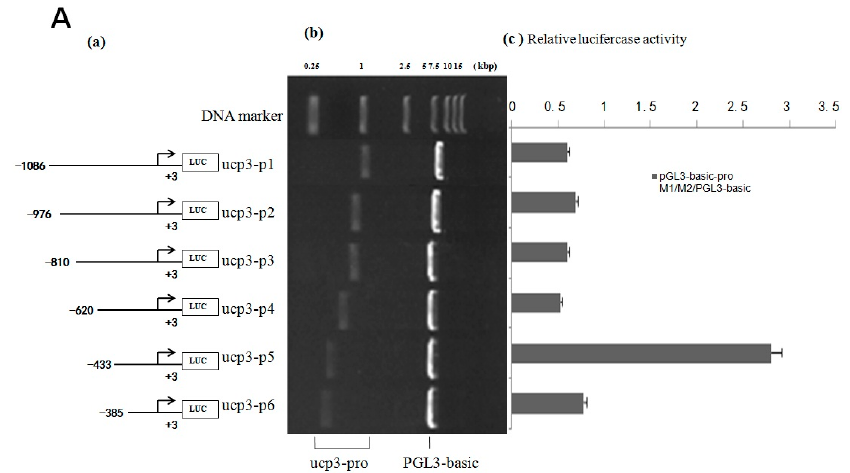
Figure 4. Cont. Figure 4.